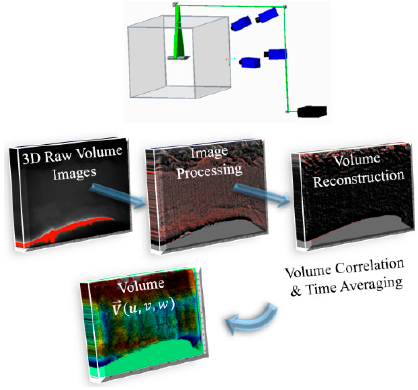
Figure 2. Basic process for multiple camera tomographic particle image velocimetry (PIV).